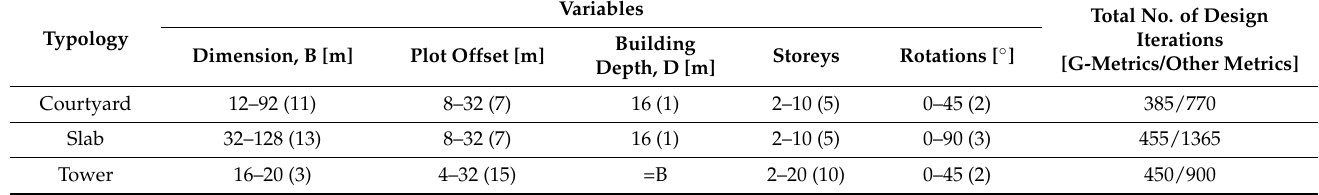
Table 1. Range (X-Y) and number (N, in brackets) of discrete variables used in neighbourhood design iterations and the total number of iterations.